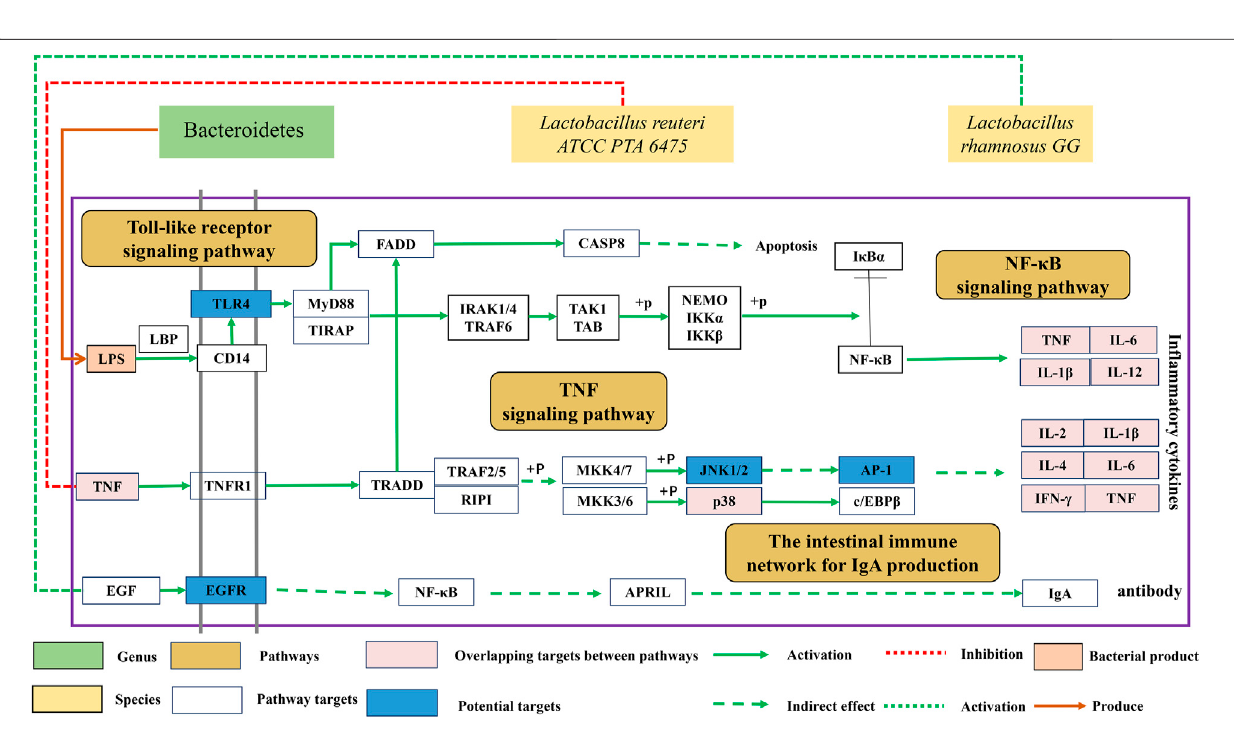
FIGURE 6 | Mechanism of FLZP regulating gut microbiota of